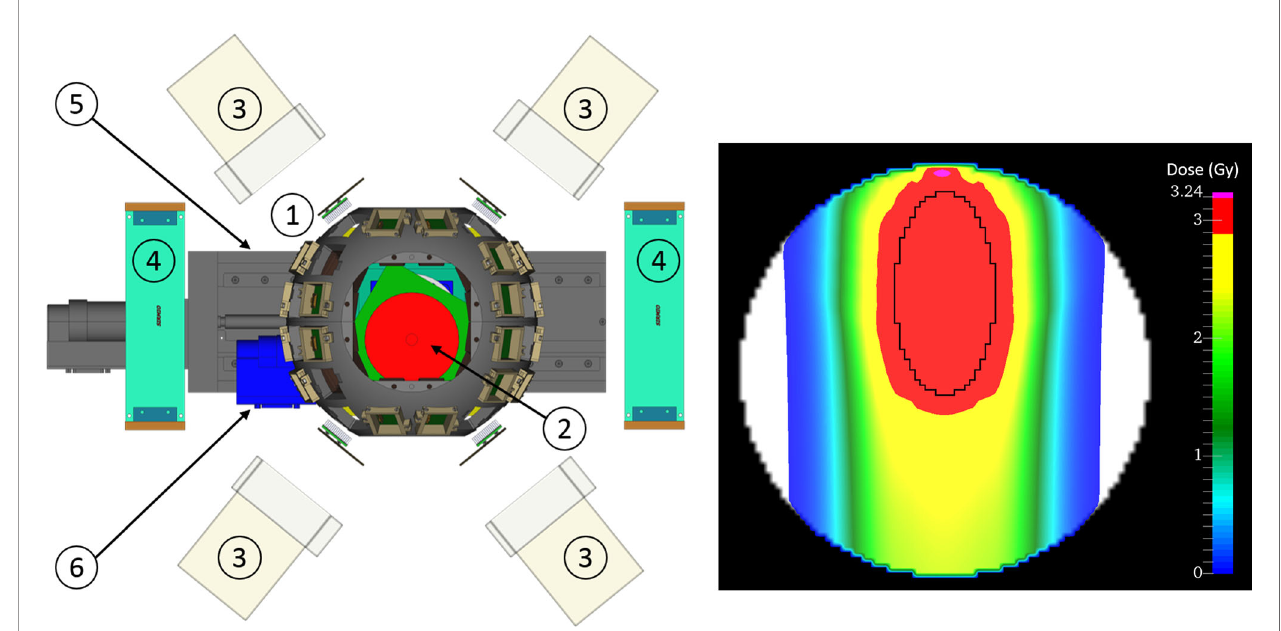
FIGURE 7 | The BARB4D setup: (1) SIRMIO cage with 32 PET detectors, (2) cylindrical phantom, (3) Compton camera, (4) Ampli fi er circuit boards for PET detectors, (5) translation stage, (6) rotating stage. The beam is entering the phantom from below. Right: Planned dose distribution for a static delivery with ellipsoidal target